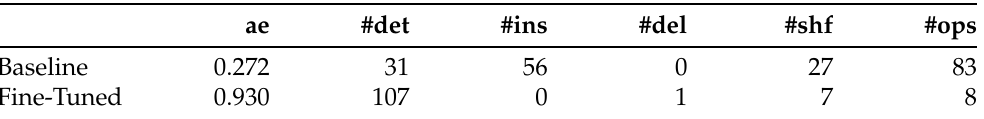
Table 4. Annotation efficiency (ae), correct detections (#det) and insertions (#ins), deletions (#del), shifts (#shf) and total edit operations (#ops) for Blue Moon